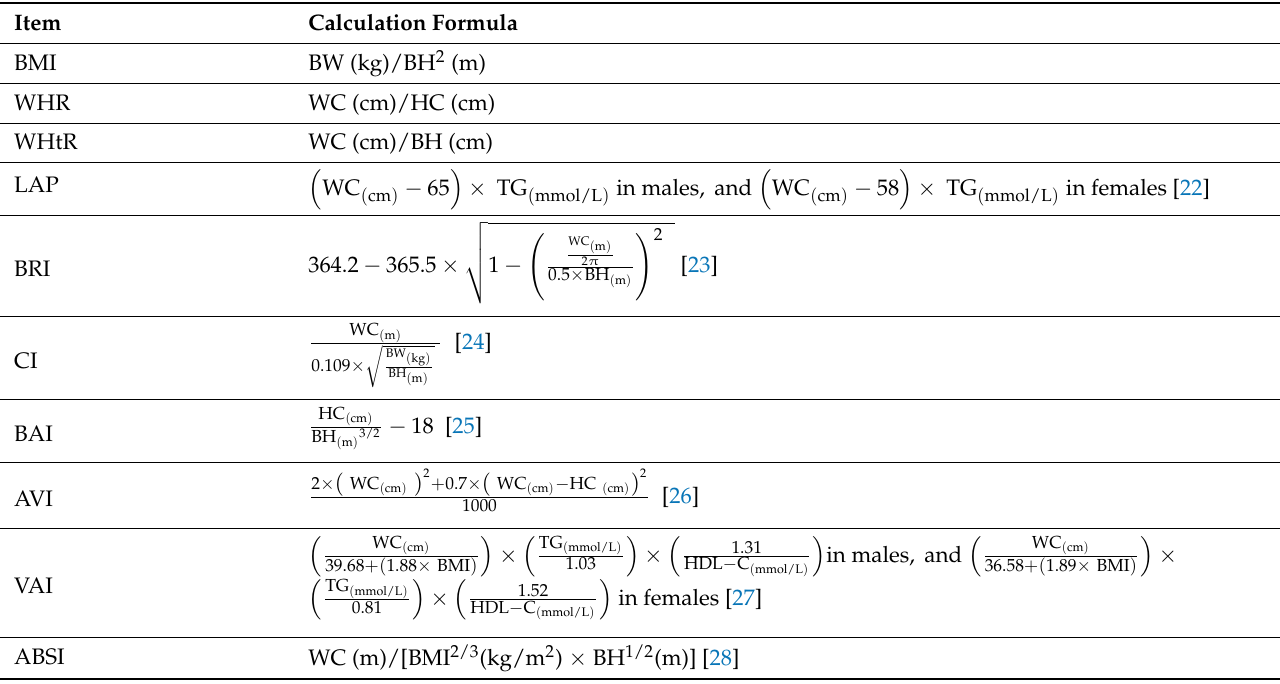
Table 1. Calculation formula of each obesity-related